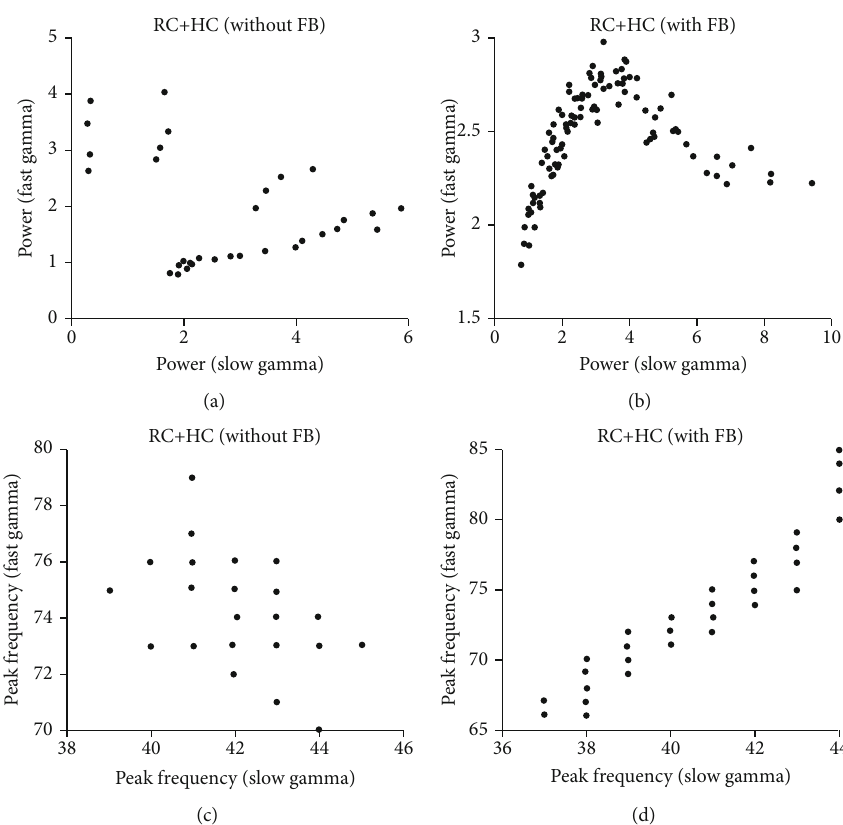
Figure 5: Relationship between gamma oscillations in the HC network without and with FB. (a) shows the scatter plot of peak power for slow ( x -axis) and fast gamma ( y -axis) in the network without FB. (b) shows the scatter plot of peak power for slow ( x -axis) and fast gamma ( y -axis) in the network with FB. (c) shows the scatter plot of peak frequency for slow ( x -axis) and fast gamma ( y -axis) in the network without FB. (d) shows the scatter plot of peak frequency for slow ( x -axis) and fast gamma ( y -axis) in the network with FB. The data points for (a) and (c) are peak powers and frequencies in di ff erent weights of HC, and for (b) and (d) are that in di ff erent weights of